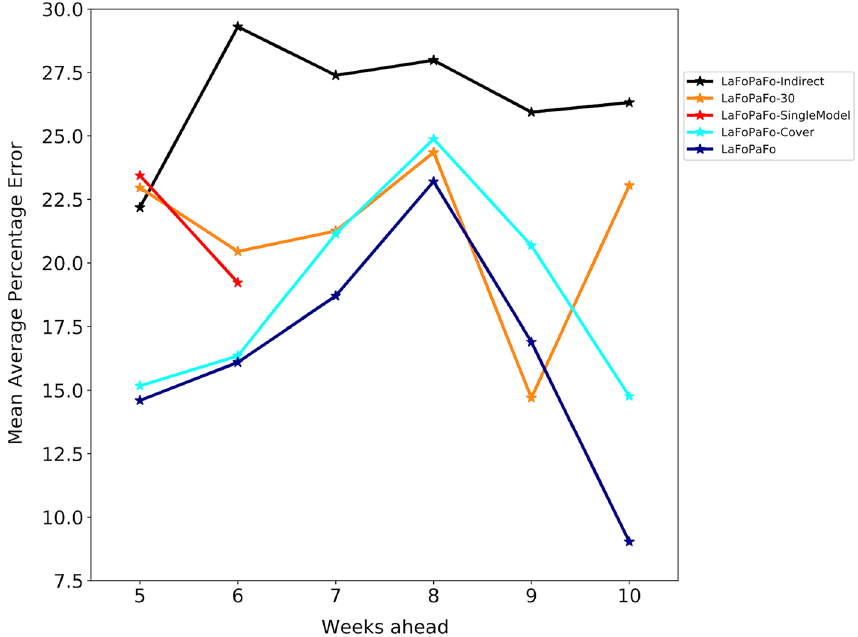
Figure 6. Ablation system, showing the LaFoPaFo’s Forecast Accuracy without various design factors. Evaluating the performance on forecasting the future number of COVID-19 deaths from 5 to 10 weeks in the future for LaFoPaFo and its modified versions (that each modify one of its design features), using the same setup as in Fig. 1. The red graph (LaPoFaPo-SingleModel) corresponds to the case where, instead of producing seven forecasting models for the seven test weeks, a single model was produced to forecast all of the 7 weeks. A validation dataset of seven instances (weeks) was used, which limited the forecast horizon to 6 weeks due to the limited training data. The cyan graph (LaPoFaPo-Cover) corresponds to the model where instead of using 11 features, only the previous number of deaths is used. The orange graph (LaPoFaPo-30) corresponds to the model where rather than the last instance, 30% of the training dataset was used as the validation set to choose the final model. The black graph (LaPoFaPo-Indirect) corresponds to the system that forecasts each week in the future based on the intermediate week forecasts, rather than being directly